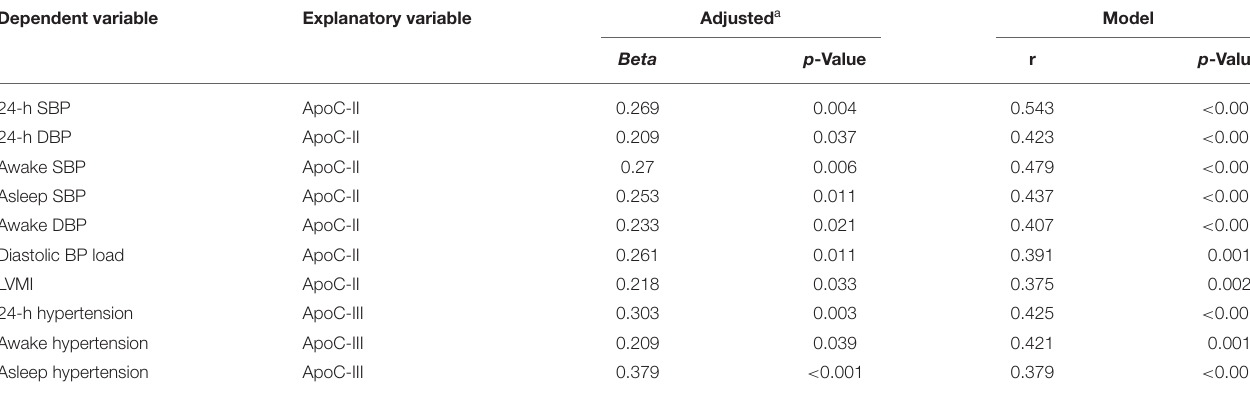
TABLE 7 | Adjusted regression model estimates of the association between plasma apoC-II, apoC-III, and surrogate markers of CV risk. Dependent variable